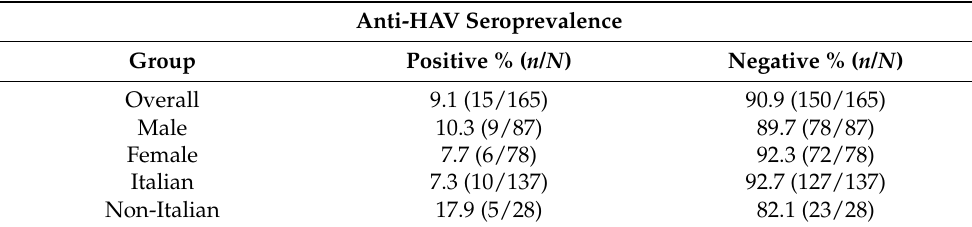
Table 2. Anti-HAV seroprevalence ( n / N : number of